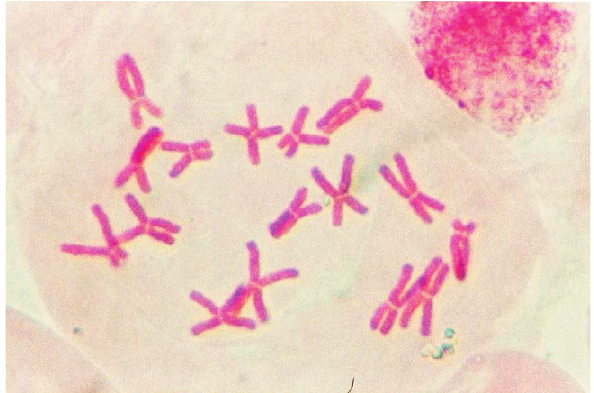
Figure 5. Different number chromosome damage in metaphase cells obtained from the meristem root-type cells of onion ( A. cepa